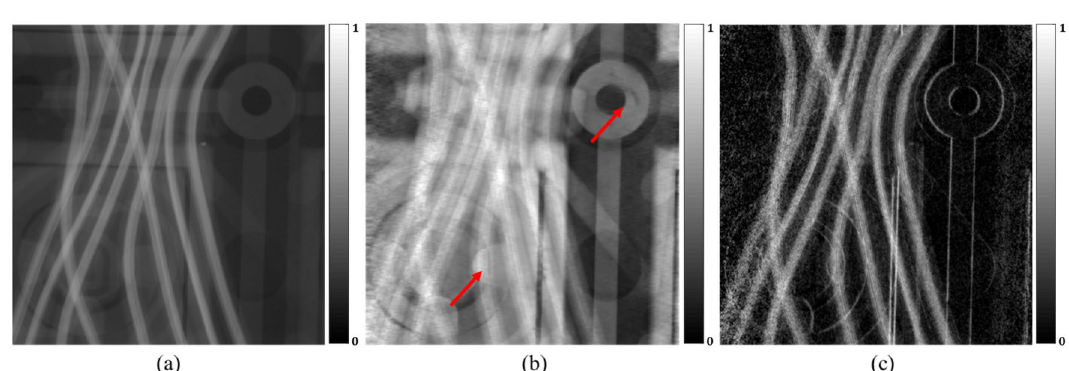
Figure 8. The grating interferometer results of the circuit sample. ( a ) Transmission, ( b ) The retrieved phase, ( c ) the dark-field. Red arrows denote missing information which cannot see in the transmission image. The phase information was retrieved with quite good quality even though there is no prior information of air